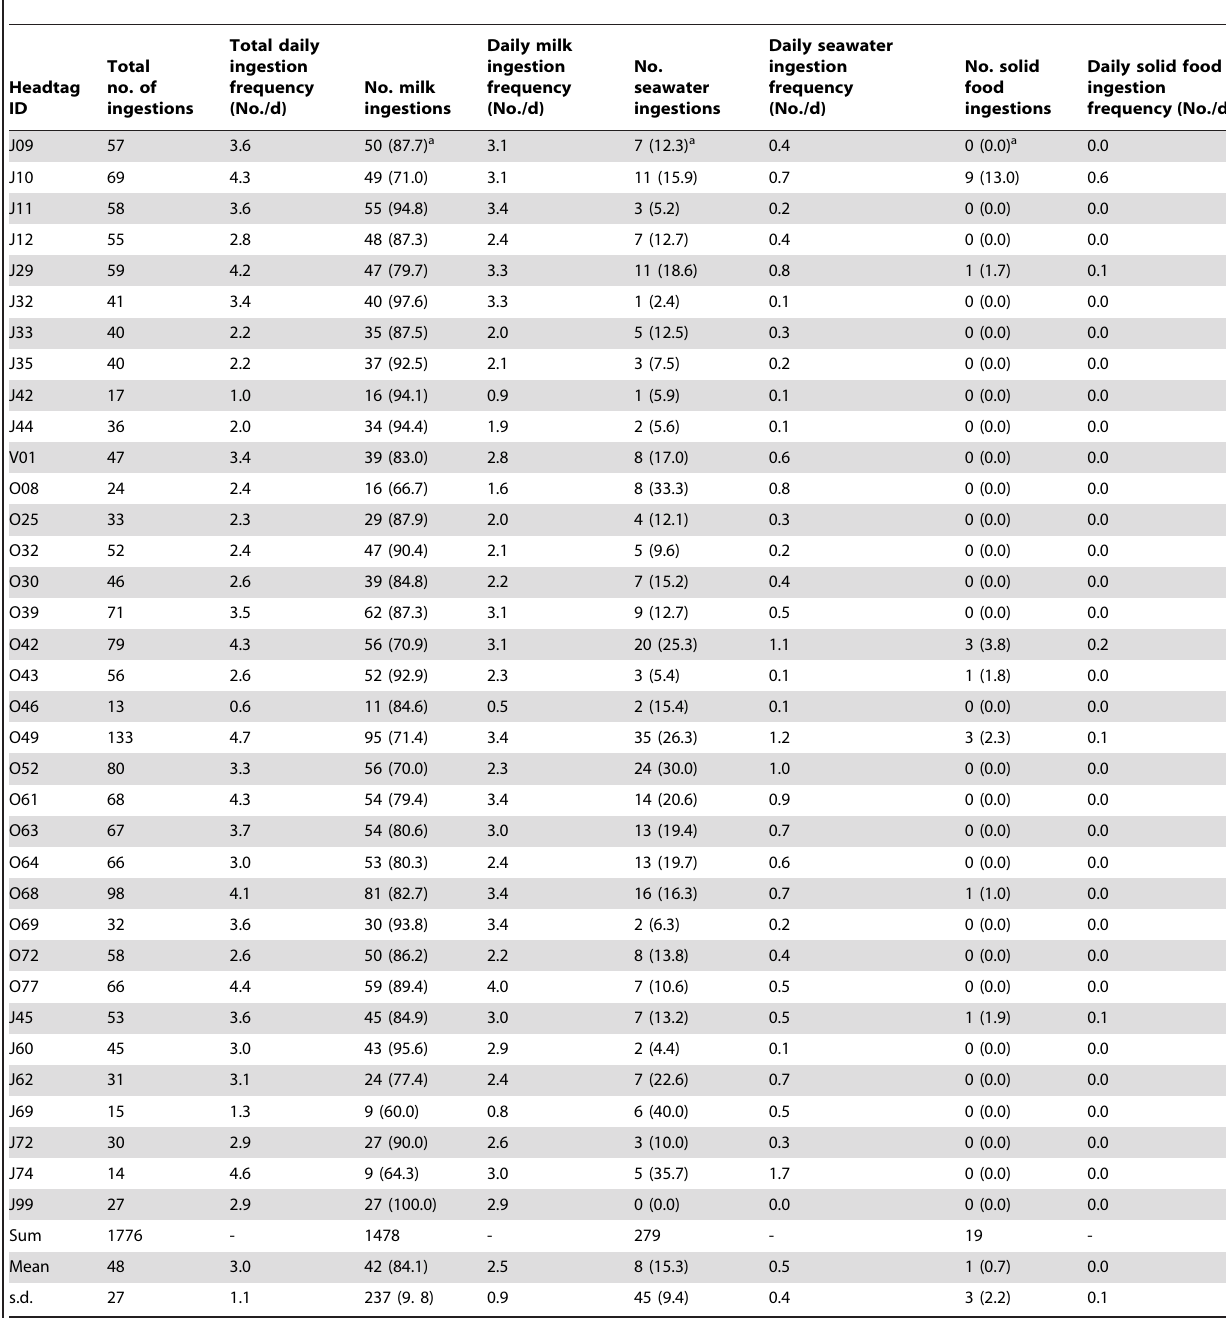
Table 6. Distribution of the PDER events ( n = 1776) recorded in nursed harbour seal pups ( n =35) equipped with TDRs and STPs among individuals and ingestion